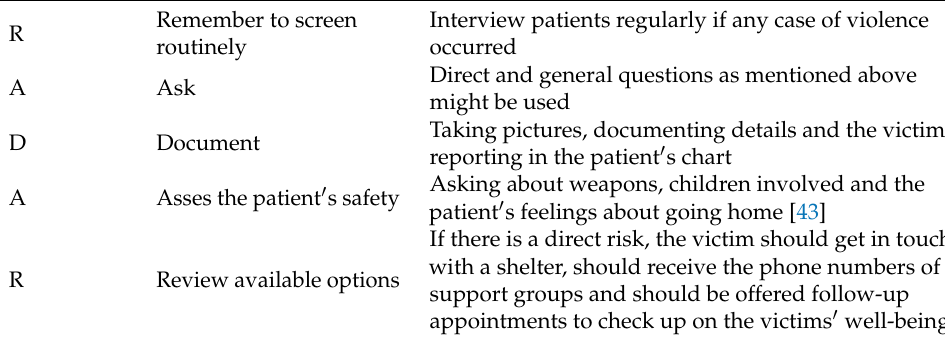
Table 9. Explanation of the R.A.D.A.R acronym with examples